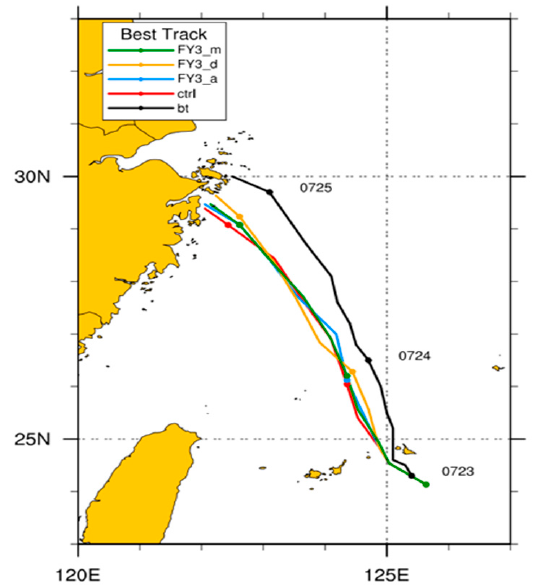
Figure 8. The best track (black) and 54 h forecast from CTRL (red), FY3_a (blue), FY3_d (yellow) and FY3_m (green) from 0000 UTC 23 July.